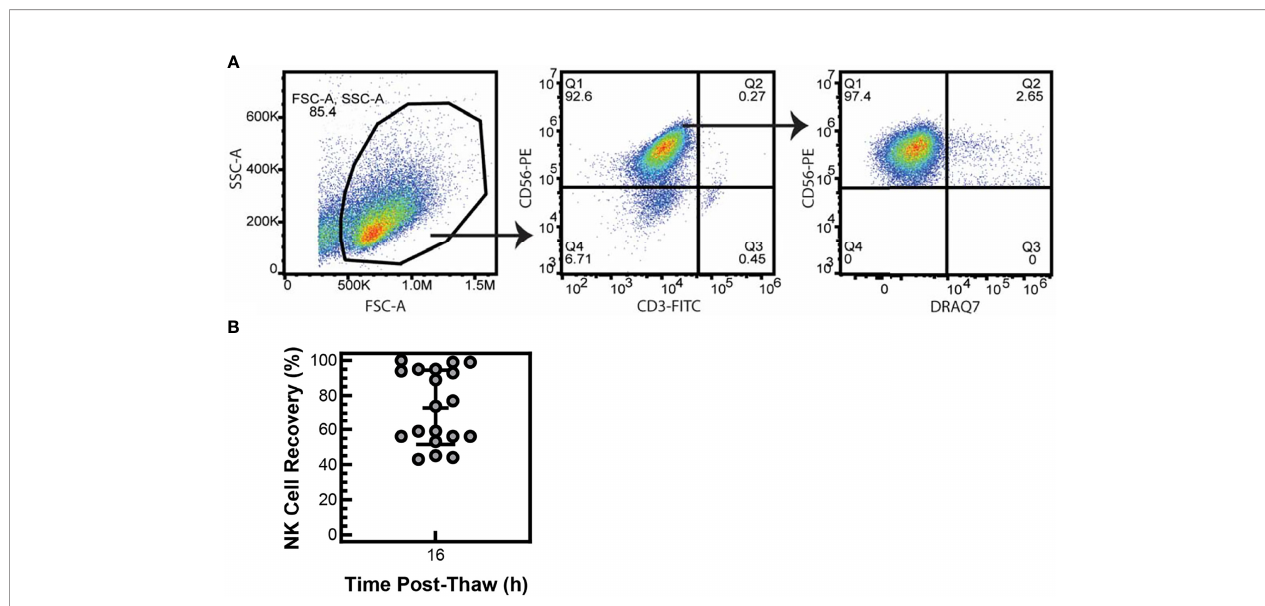
FIGURE 1 | NK cells are viable after cryopreservation. NK cells were expanded with PM21 particles (PM21-NK cells) from T-cell-depleted PBMCs obtained from multiple donors (N = 19). Cells were cryopreserved and stored in liquid nitrogen until use. Frozen PM21-NK cells were thawed and counted for number of viable NK cells, and no loss of NK cells was seen. Representative fl ow cytometry dot plots gating for viable (Draq7 - ) NK (CD3 - , CD56 + ) cells immediately post-thaw are shown (A) . Thawed NK cells were placed in media at 1 × 10 7 of viable cells and rested overnight at 37°C. After 16 h, the total number of viable NK cells was counted. Percent recovery at 16 h post-thaw was calculated by dividing the total number of viable cells, remaining after 16 h rest, by 1 × 10 7 . Mean recovery was 73% ± 22% (B) . Data are represented as a scatter plot with an error bar representing standard